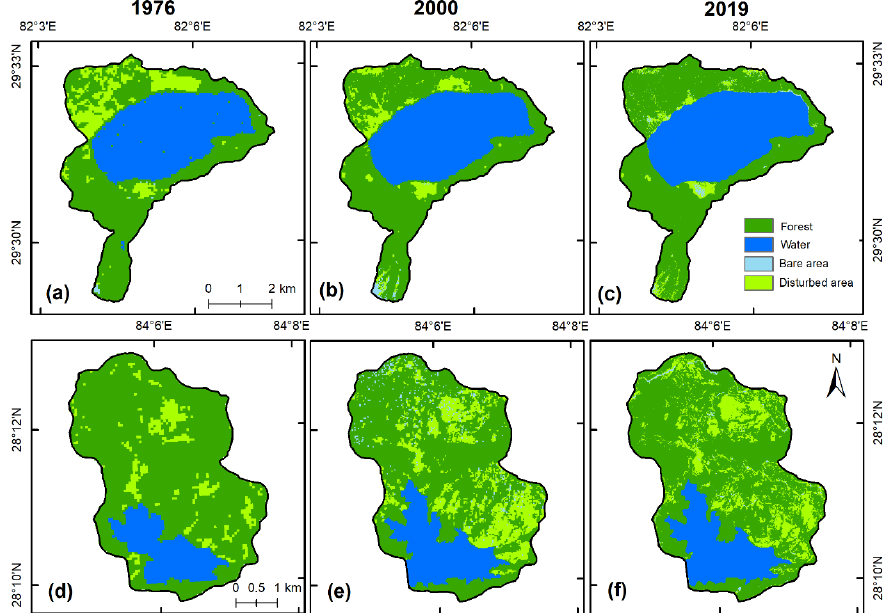
Figure 7. Land-cover change of Rara ( a – c ) and Begnas ( d – f ) watersheds between 1976 and 2019.